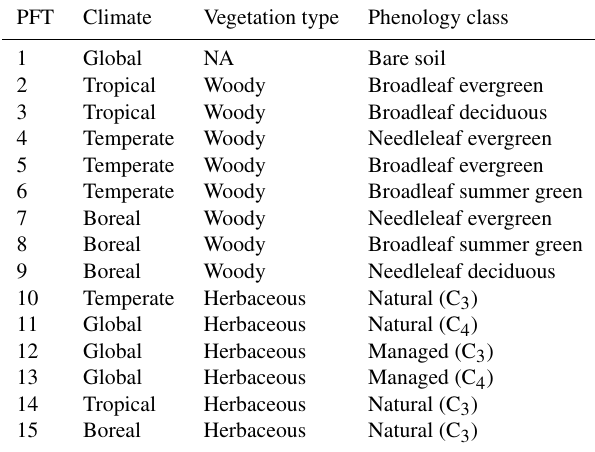
Table 1. Description of the 15 PFTs used in ORCHIDEE to repre- sent global